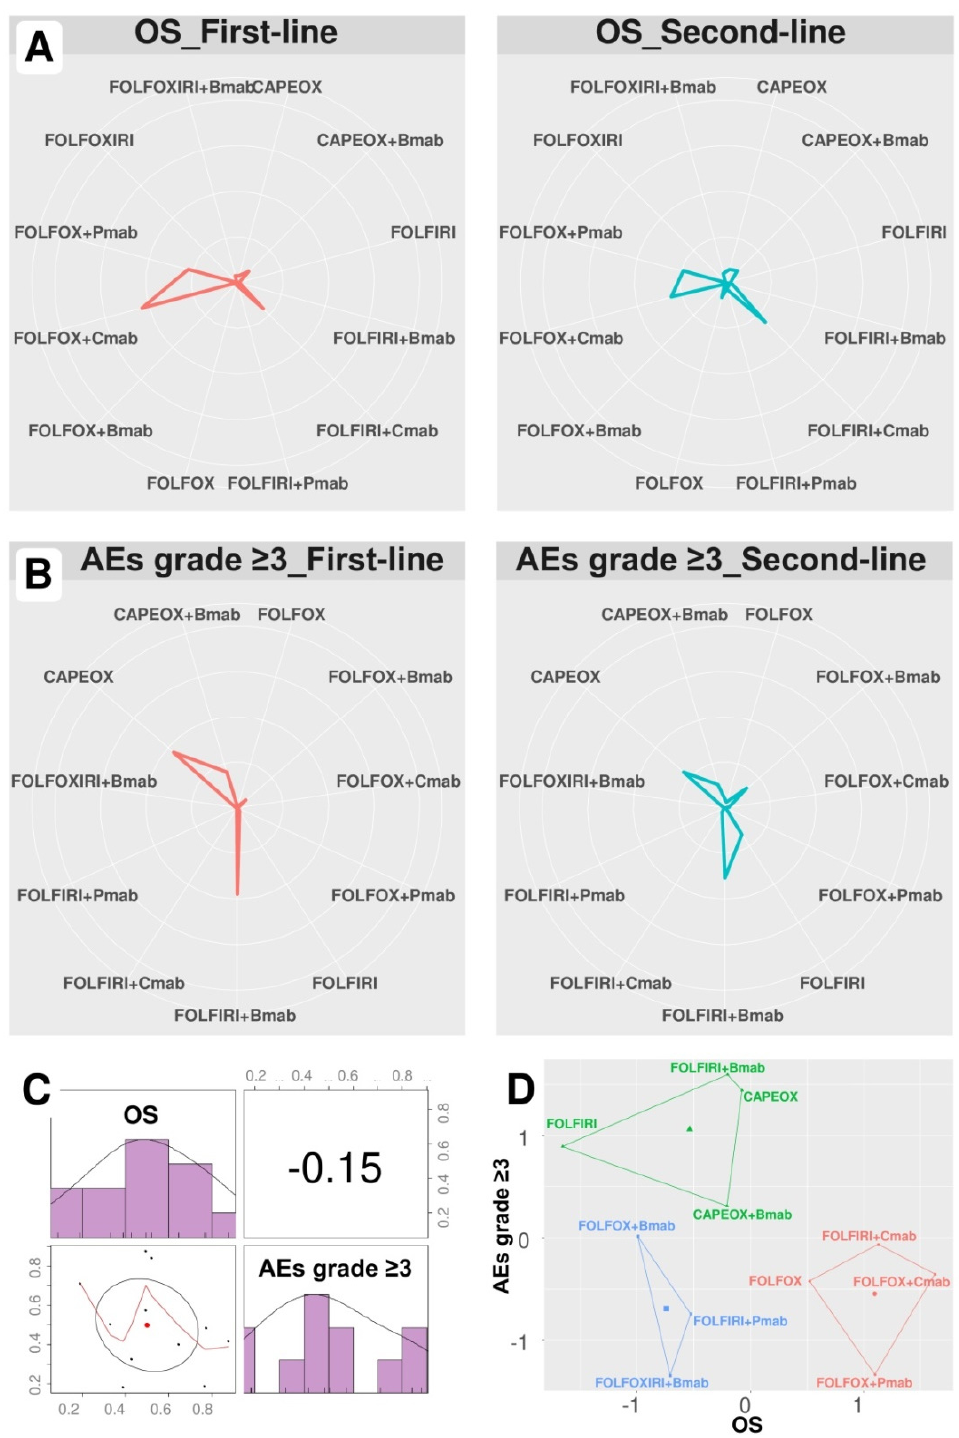
Figure 2. Treatment ranking probability and SUCRA ranking plots. Data are presented as the probability of first- and second-line treatment ranking according to ( A ) overall survival and ( B ) adverse events grade ≥ 3. ( C ) Correlation and ( D ) k-means clustering analysis of SUCRA values. FOLFOX (5-fluorouracil, folinic acid, and oxaliplatin), FOLFIRI (5-fluorouracil, folinic acid, and irinotecan), FOLFOXIRI (5-fluorouracil, folinic acid, oxaliplatin, and irinotecan), CAPEOX (capecitabine and oxaliplatin), Bmab (bevacizumab), Cmab (cetuximab), Pmab (panitumumab), OS (overall survival), and AEs (adverse events).